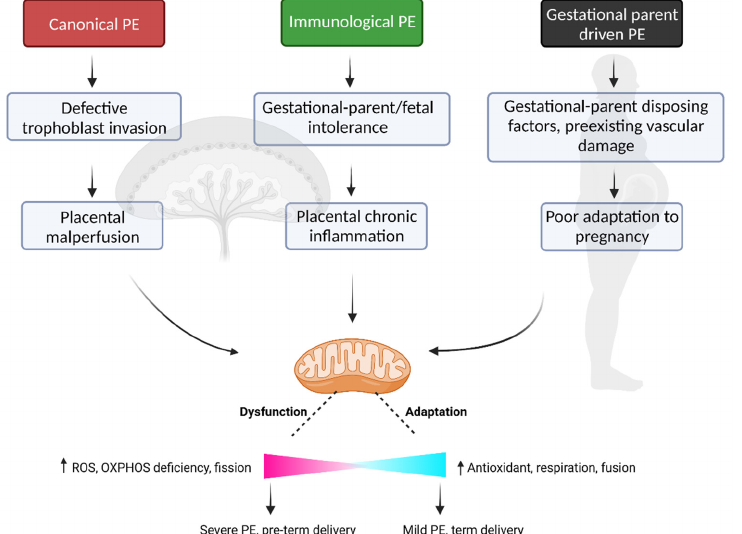
Figure 1. Mitochondrial dysfunction as a common feature across all PE subclasses. PE disease driven by either placental malperfusion, chronic inflammation at the utero–placental interface and/or poor gestational parent adaptation, likely all demonstrate altered mitochondrial respiration, increased ROS production and mitochondrial fragmentation within the placenta and across numerous gestational parent tissues. The inherent ability of the mitochondria to adapt during pregnancy to various pathological insults may in part dictate the clinical outcome of the pregnancy, with high degrees of mitochondrial adaptation associated with a milder clinical presentation of the disease, prolonged gestation, and improved fetal growth profiles. The “ ↑ ” arrow indicates an increase. Figure was created with Biorender.com, accessed on 24 January 2023.